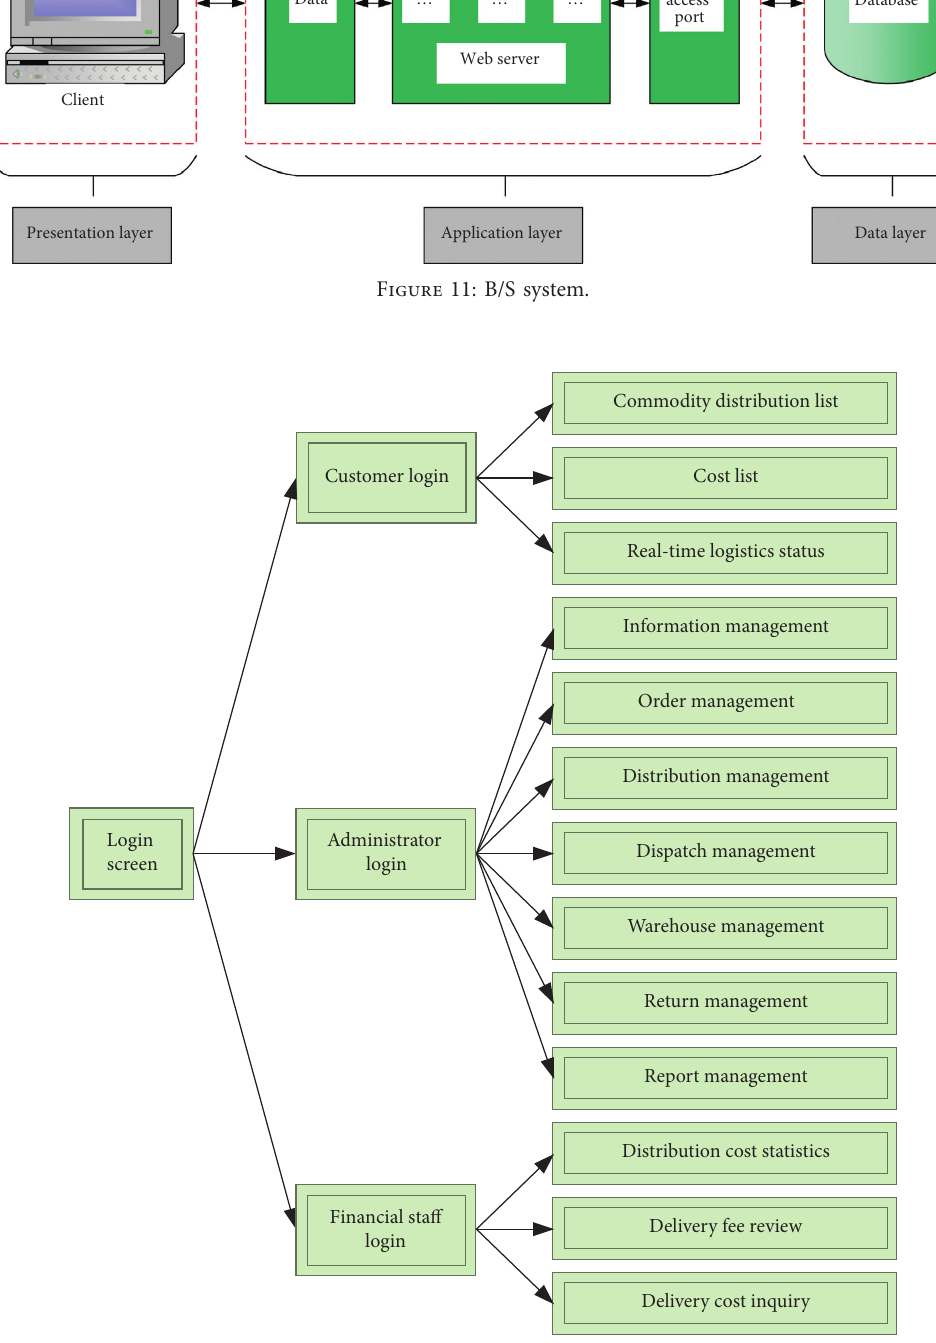
Figure 12: Structure of the intelligent logistics distribution management system.